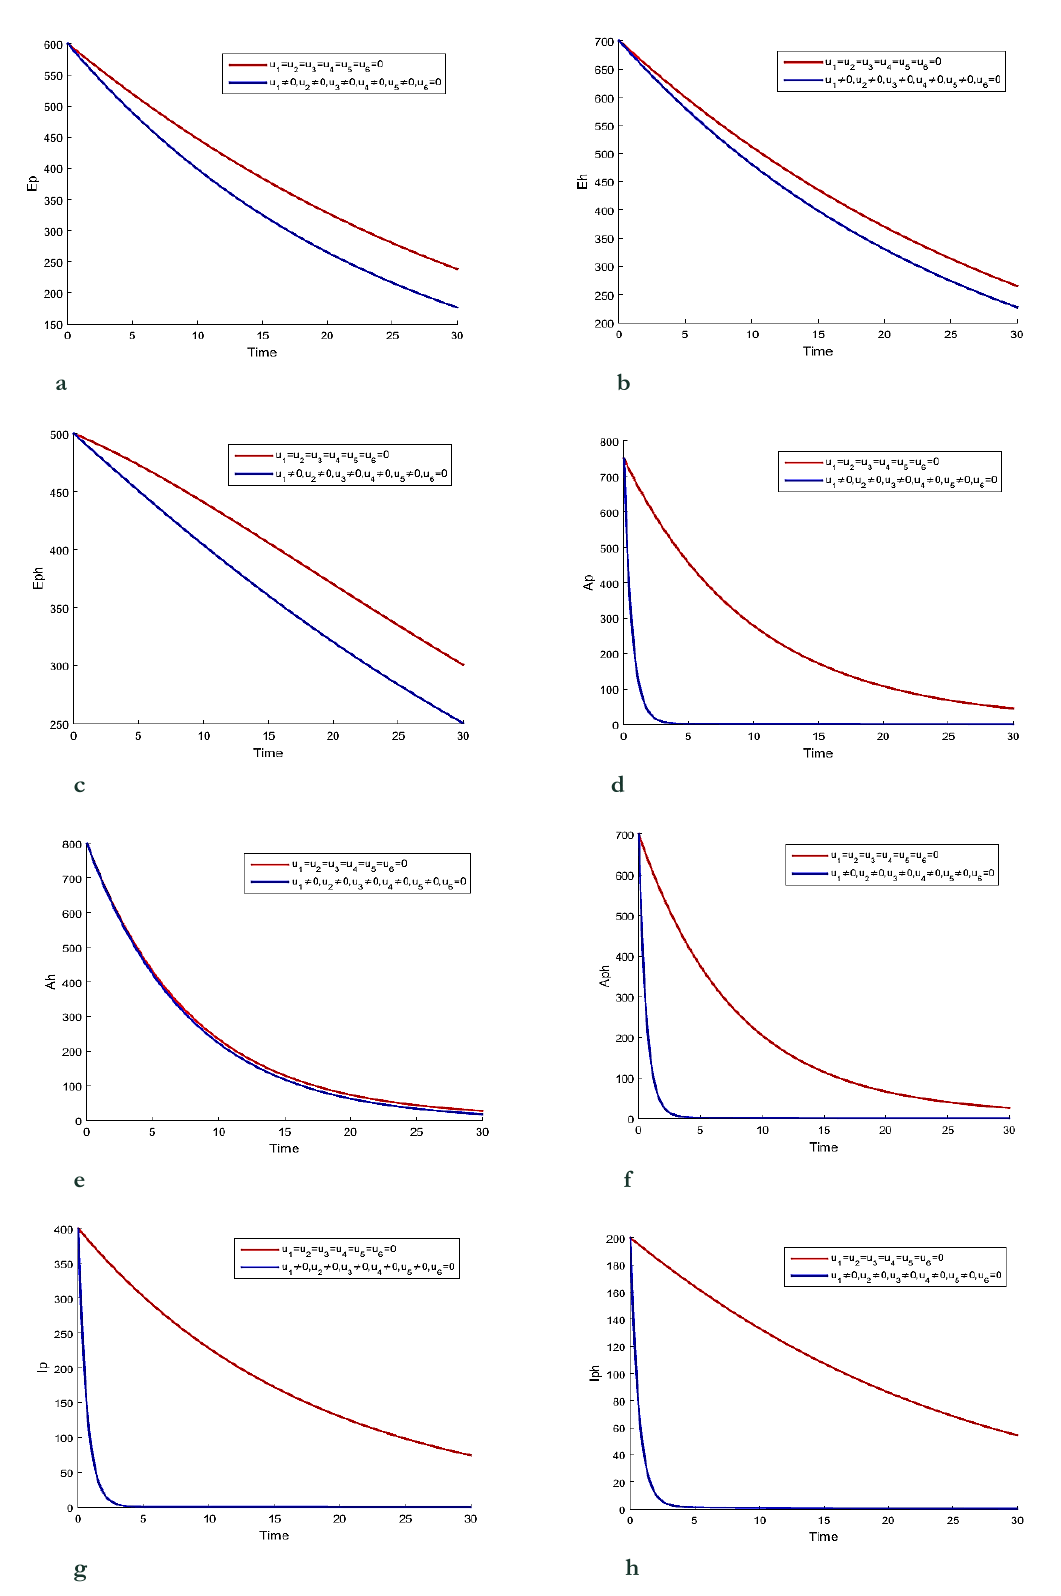
, 𝐮 , 𝐮 , 𝐮 and 𝐮 𝟏 𝟐 𝟑 𝟒